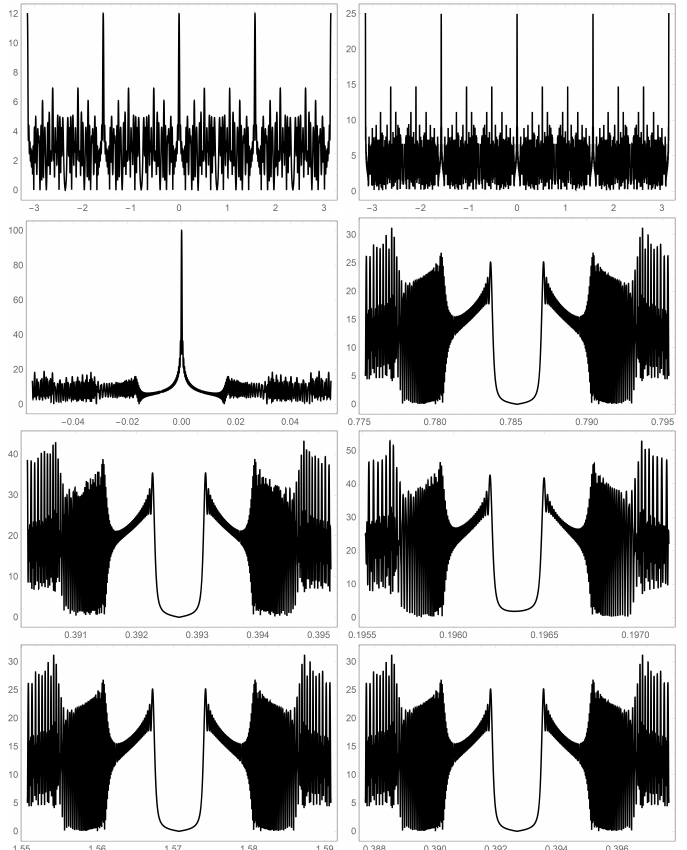
Figure 15. The lacunary trigonometric system obtained from L ( C ( 4 ) ; z ) by setting z = e i φ . The top row compares the full range − π < φ < π for the case of N = 12 ( left panel ) and N = 25 ( right panel ). The left panel in the second row shows a blow-up around φ = 0 and N = 100. The right panel in the second row and the two panels in the third row expose the scaling property of the system. Note the similarity of the graphs. The right panel in the second row is at the first symmetry angle, φ = π , with N = 250 and a 4 plot range of 0.02. The left panel in the third row is centered at the second symmetry angle, φ = π , now 8 with N = 500 and a full plot domain of a fourth of that of the second row right panel. The right panel in the third row is centered at the third symmetry angle, φ = π . Here, N = 750 and a full plot domain is 12 one-twelfth that of the second row right panel. The bottom row shows scaling similarity across different values of k . The first symmetry angle is shown. The bottom left panel shows the case of L ( C ( 2 ) ; z ) and the right panel shows the case of L ( C ( 8 ) ; z ) . In both cases N = 250. For the k = 2 case, the range is twice that for the k = 4 case, while for the k = 8 case, the range is half that of k =